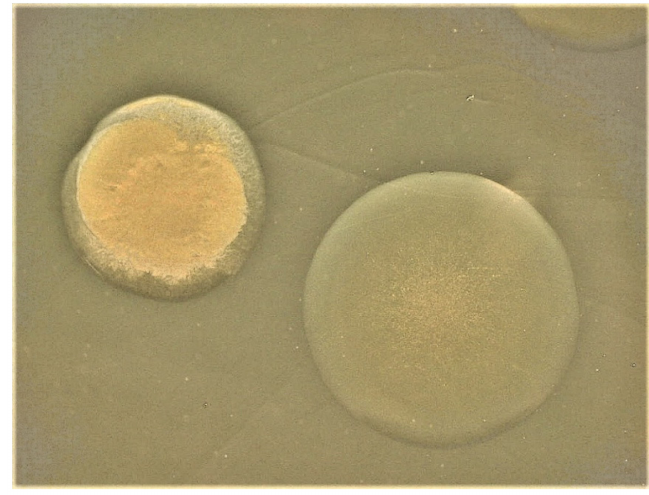
Figure 1. Opaque (left) and translucent (right) colony types of V. vulnificus